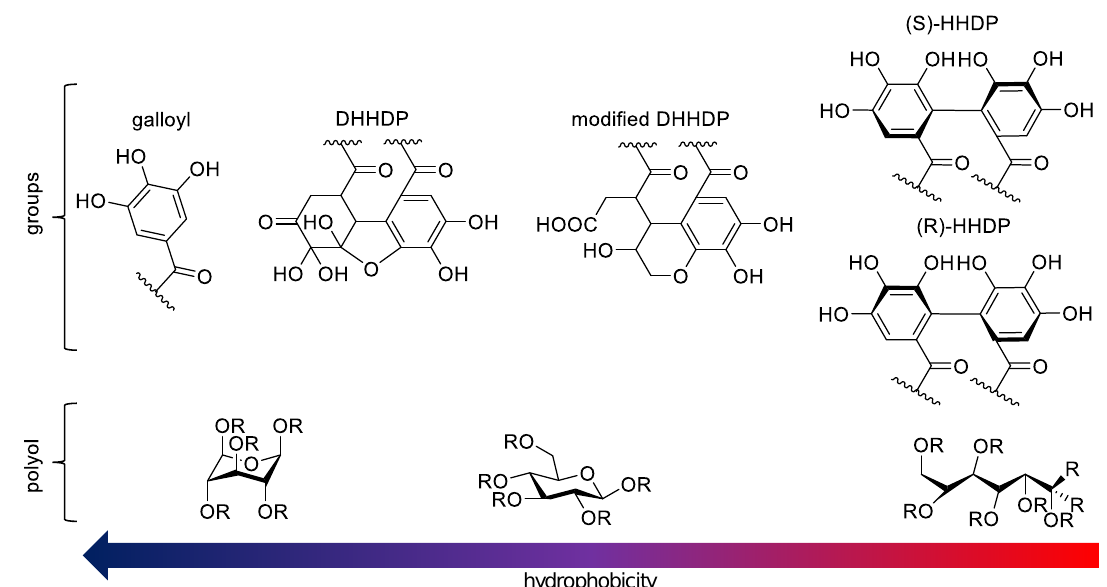
Figure 6. Graphic example of the e ff ects of structural groups and the conformation of the polyol glucose of di ff erent hydrolysable tannins on the hydrophobicity. DHHDP = dehydrohexahydroxydiphenoyl, HHDP = hexahydroxydiphenoyl. R can be for instance hydrogen, hydroxyl, galloyl, HHDP or other ET substitute group.